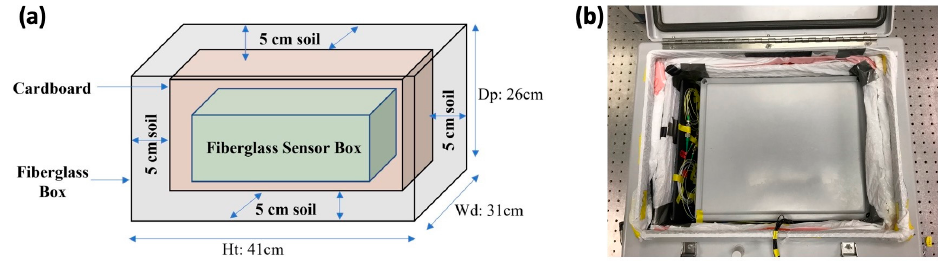
Figure 2. ( a ) Layout of the insulation chamber with the soil insulation layer. ( b ) A picture showing the inside of the insulation chamber.